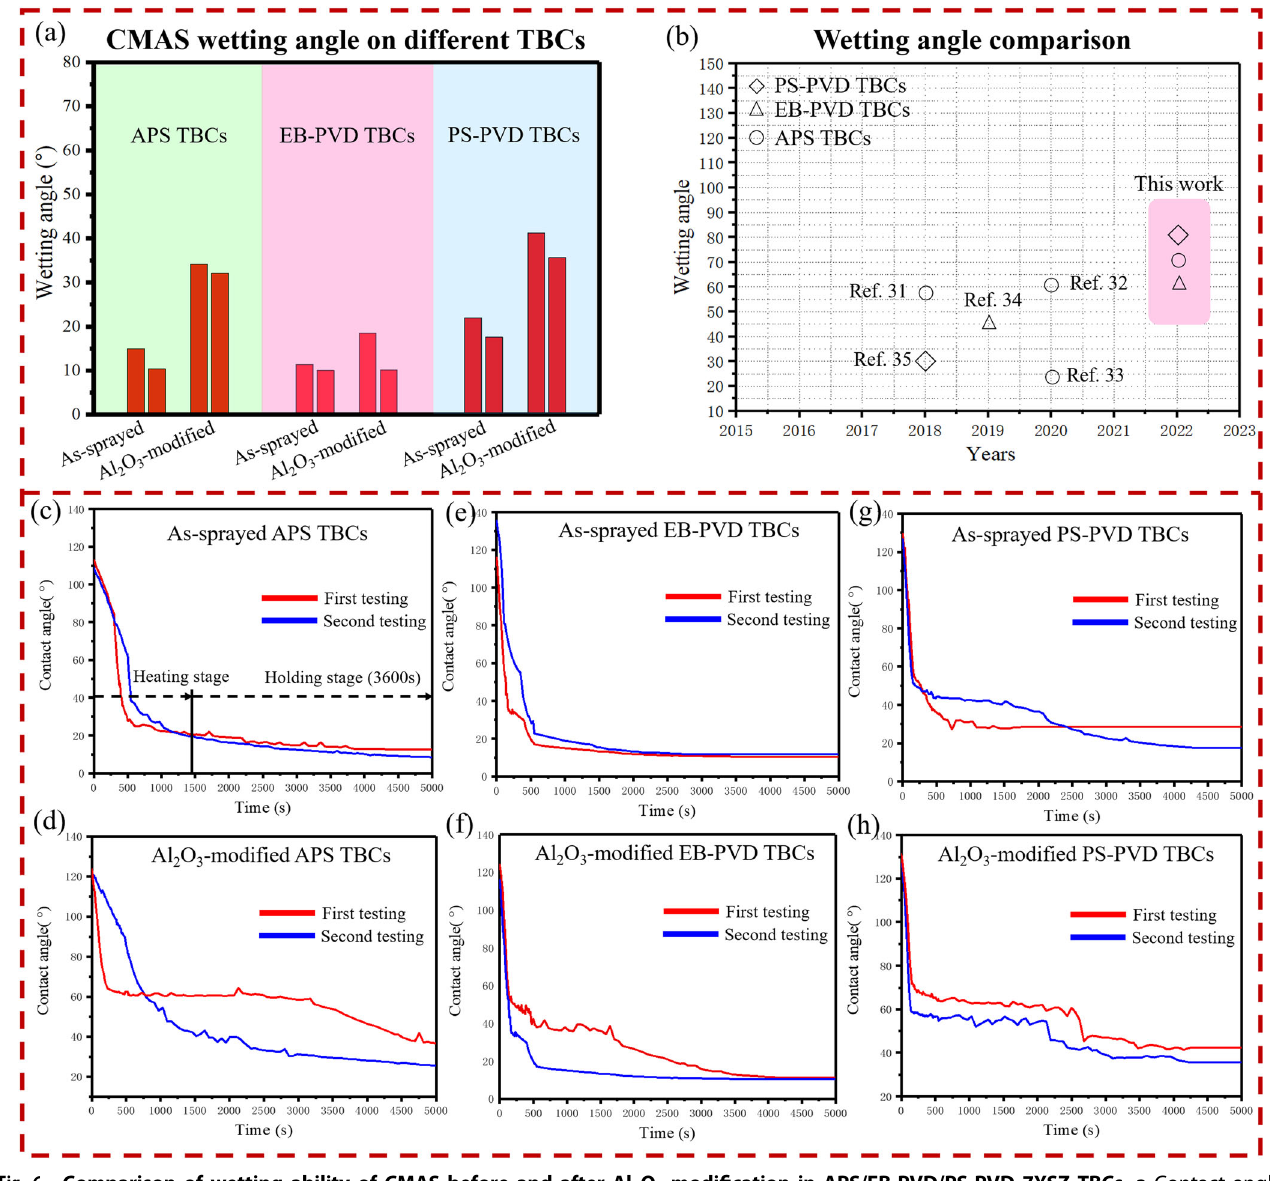
Fig. 6 Comparison of wetting ability of CMAS before and after Al 2 O 3 -modi fi cation in APS/EB-PVD/PS-PVD 7YSZ TBCs. a Contact angle comparison among APS/EB-PVD/PS-PVD TBCs. b Contact angle comparison with published literature. c – h Contact angle variation with increasing time at 1250